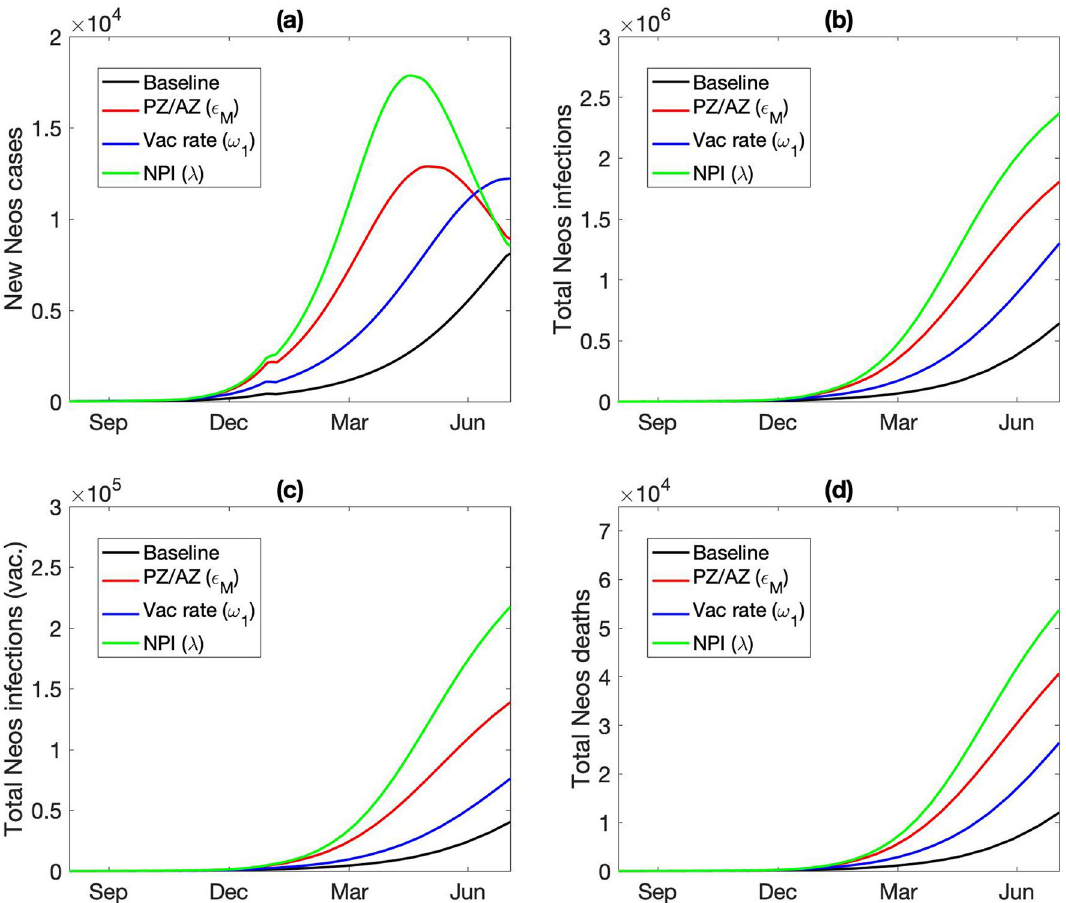
Figure 10. Predicted spread of hypothetical VOC “Neos,” shown from August 1 2021 to June 31 2022. Results are obtained for baseline parameters and three alternative scenarios. “PZ/AZ,” lower fraction of vaccines being Pfizer (from 95 to 40%), with the reduction made up with AstraZeneca, which offers reduced protection from Delta infections and a longer dosing delay. “Vac rate,” vaccination rate reduced by 20%. “NPI”, less stringent lockdown measured, with mobility increased by 25%. ( a ) Number of new Neos infections. ( b ) Total number of Neo infections. ( c ) Total number of vaccinated individuals infected with Neos. ( d ) Cumulative dealths from Neos